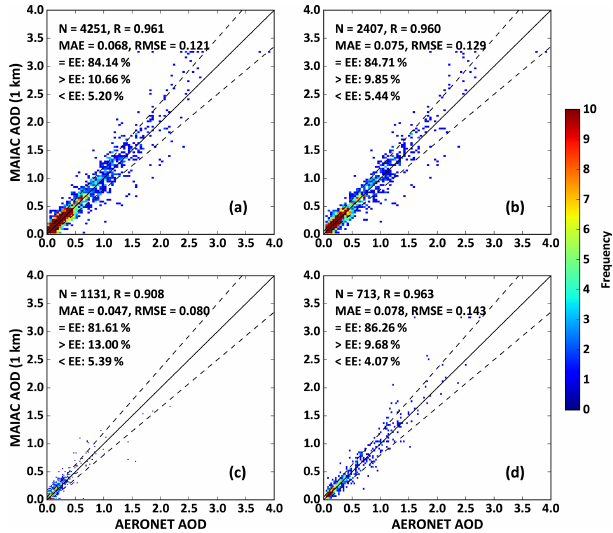
Figure 2. Scatter plots of MAIAC AOD retrievals versus AERONET AODs at 550nm in (a) China and (b) urban, (c) crop- land and (d) grassland areas. The dotted lines represent the upper and lower boundaries of the expected error (EE). Statistical metrics are given in each panel, including the number of samples ( N ), the correlation coefficient ( R ), the mean absolute error (MAE) and the root-mean-square error